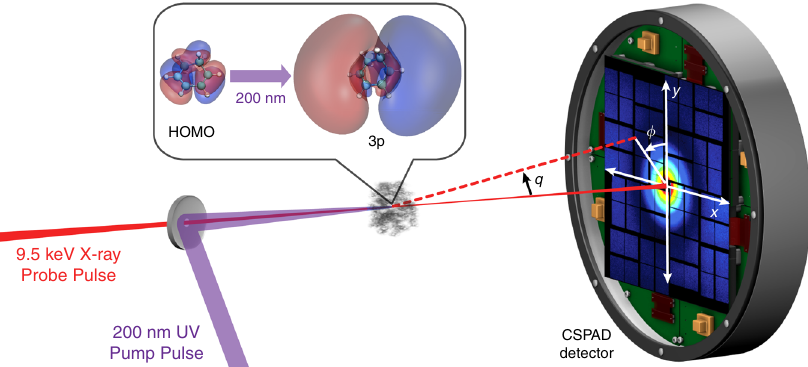
Fig. 1 A schematic of the experimental set-up. The CHD molecules are excited by a 200 nm UV pump pulse and the molecules are probed by 9.5 keV x- ray pulses with a variable time delay. The scattering signals are recorded on a CSPAD detector. The insert shows the highest occupied molecular orbital (HOMO), which has π character, and the excited 3p molecular orbital. Both orbitals are rendered at 5% of maximum ISO values at the ground-state molecular